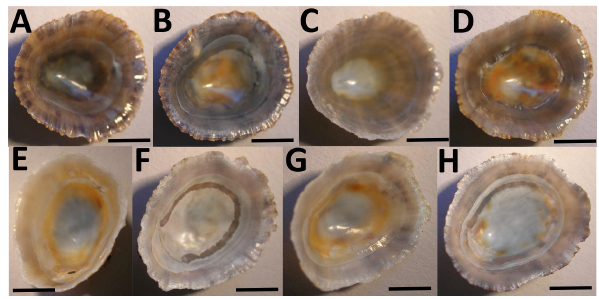
Figure 10. Photographs of the analysed shells. Shells sampled at the control site, i.e. at normal pH (a–d) . Shells sampled at the vent site, i.e. at low pH (e–h)